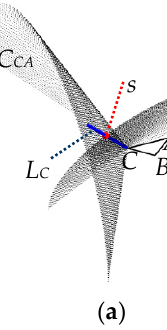
Figure 10. Schematic diagram of 3D-DOA estimation based on the UTA. ( a ) L C determined by C CA and C CB . ( b ) s determined by L C and L B